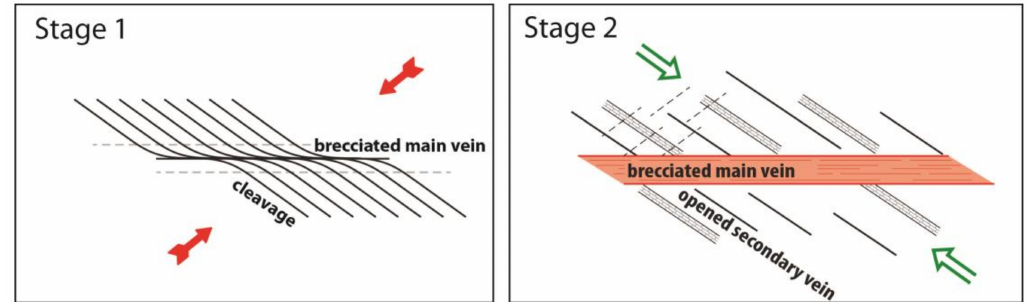
Figure 2. Example of re-using and re-opening of a previously formed left-lateral shear zone during two different states of stress. Red and green arrows correspond to the shortening direction of each stage. Note that main infilling is realised during stage